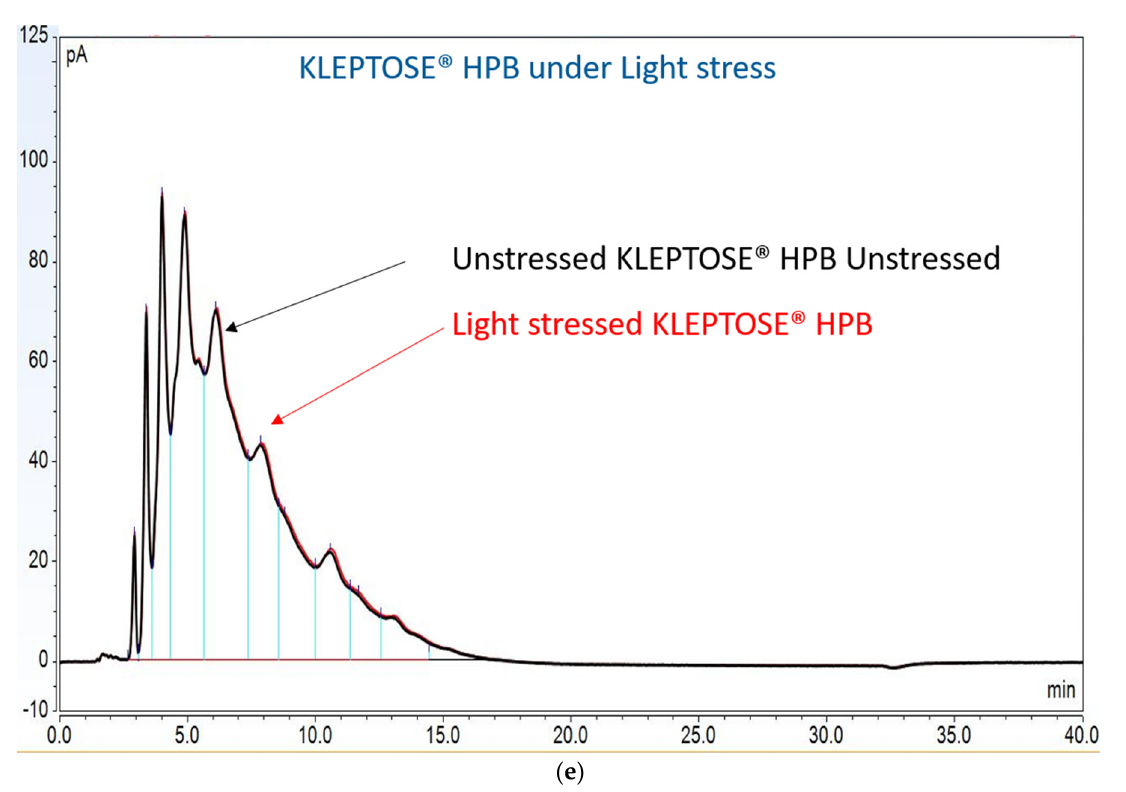
Figure 7. The degradation of POE sorbitan esters in PS 20 ( A ) and PS 80 ( B ); Profiling characterization KLEPTOSE®HPB under autoclave ( C ), oxidative ( D ), and light stresses ( E ). * p < 0.05, ** p < 0.01, *** p < 0.001, and **** p <